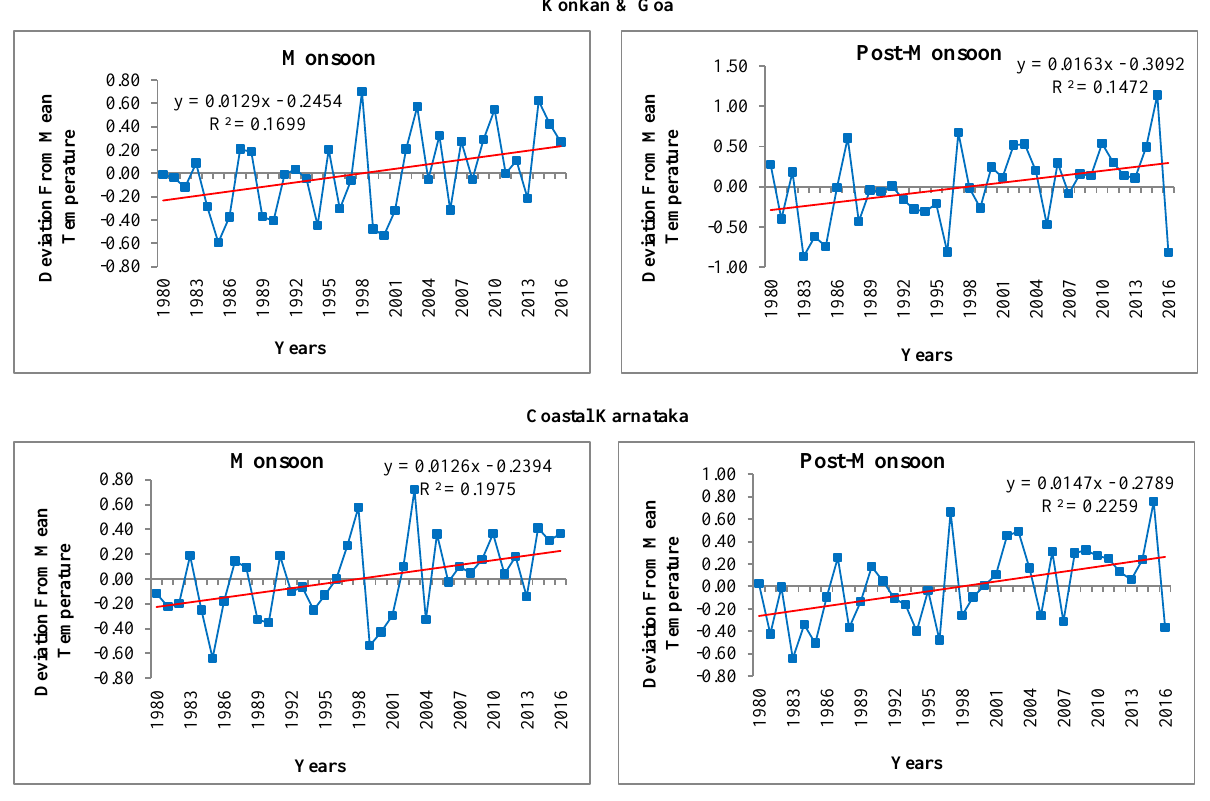
Figure 10. Trends in temperature of monsoon and post-monsoon over both the subdivisions Monthly: Mere analyses of Mean monthly surface temperature records are susceptible to errors because of possibilities of various inconsistencies. The main aim of present study was to detect the degree of warming or cooling in the region using regression technique which is known to produce ‘true’ estimates of the climate change as compared with the other available methods. The study was aimed at extending the knowledge of historical temperature change by combining the temperature data acquired from MEERA-2 and meteorological data from IMD. Monthly trends of temperature over Konkan and Goa were shown in Figure 11. The diagrams were clearly stated that all monthly trends were positive but the intensity of change is high in the months of January (0.42°C), March (0.43°C), April (0.53°C), May (0.49°C), October (0.41°C) and in December (0.42°C). Figure 12 shows monthly temperature trends over coastal Karnataka. All months shows positive change i.e. temperature over the time period is increasing and its intensity is high in the month of March (0.3°C), April (0.3°C), July (0.3°C), August (0.31°C), September (0.32°C), October (0.33°C) and November (0.34°C). This approves that the warming obtained by the analysis of temperature data carries the characteristics of climate of the region and establishes that Western Ghats region of India has witnessed a significant increase in temperature during a time-spam of 40 years i.e.,